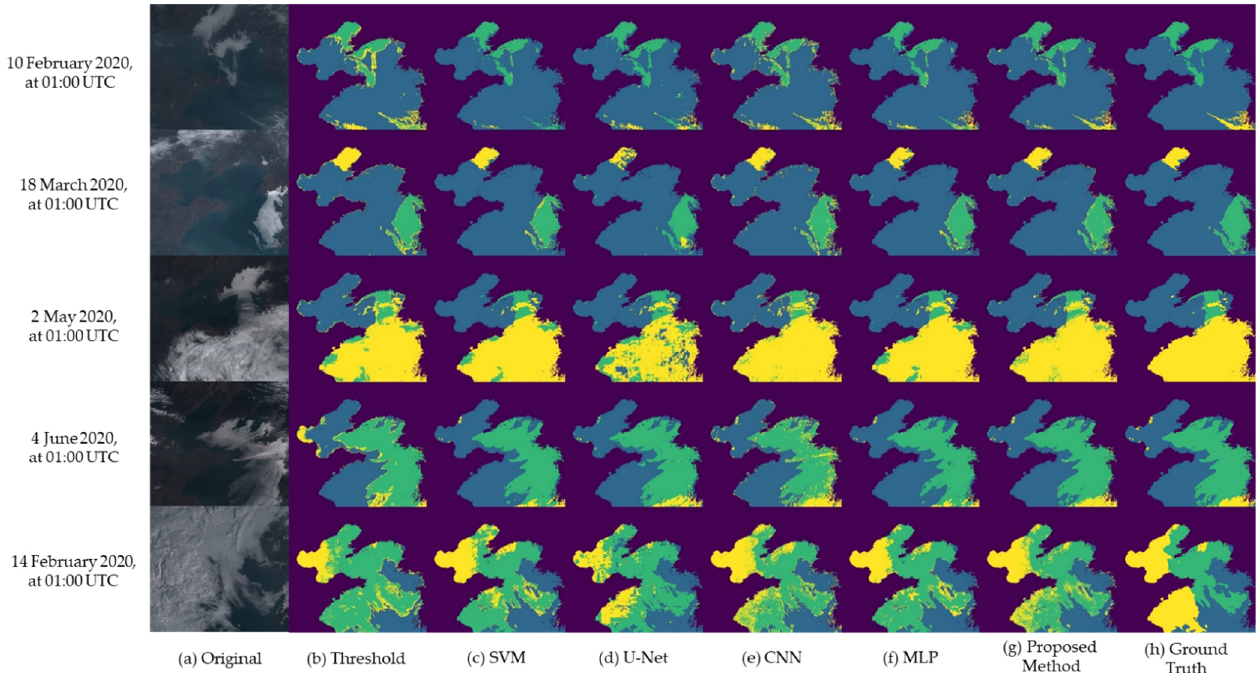
Figure 6. Detection results of five different sea fog events occurred during 2020 using six different algorithms. Each row represents a sea fog event, and its observation time is displayed on the left. Each column represents: ( a ) original Himawari-8 images, ( b ) results of threshold method [12] , ( c ) results of the SVM method, ( d ) results of the U-Net method, ( e ) results of the CNN, ( f ) results of the MLP, ( g ) results of the proposed method, ( h ) ground truth of the corresponding images of ( a ). The clouds, clear sky, and sea fog pixels are marked yellow, blue, and green, respectively.